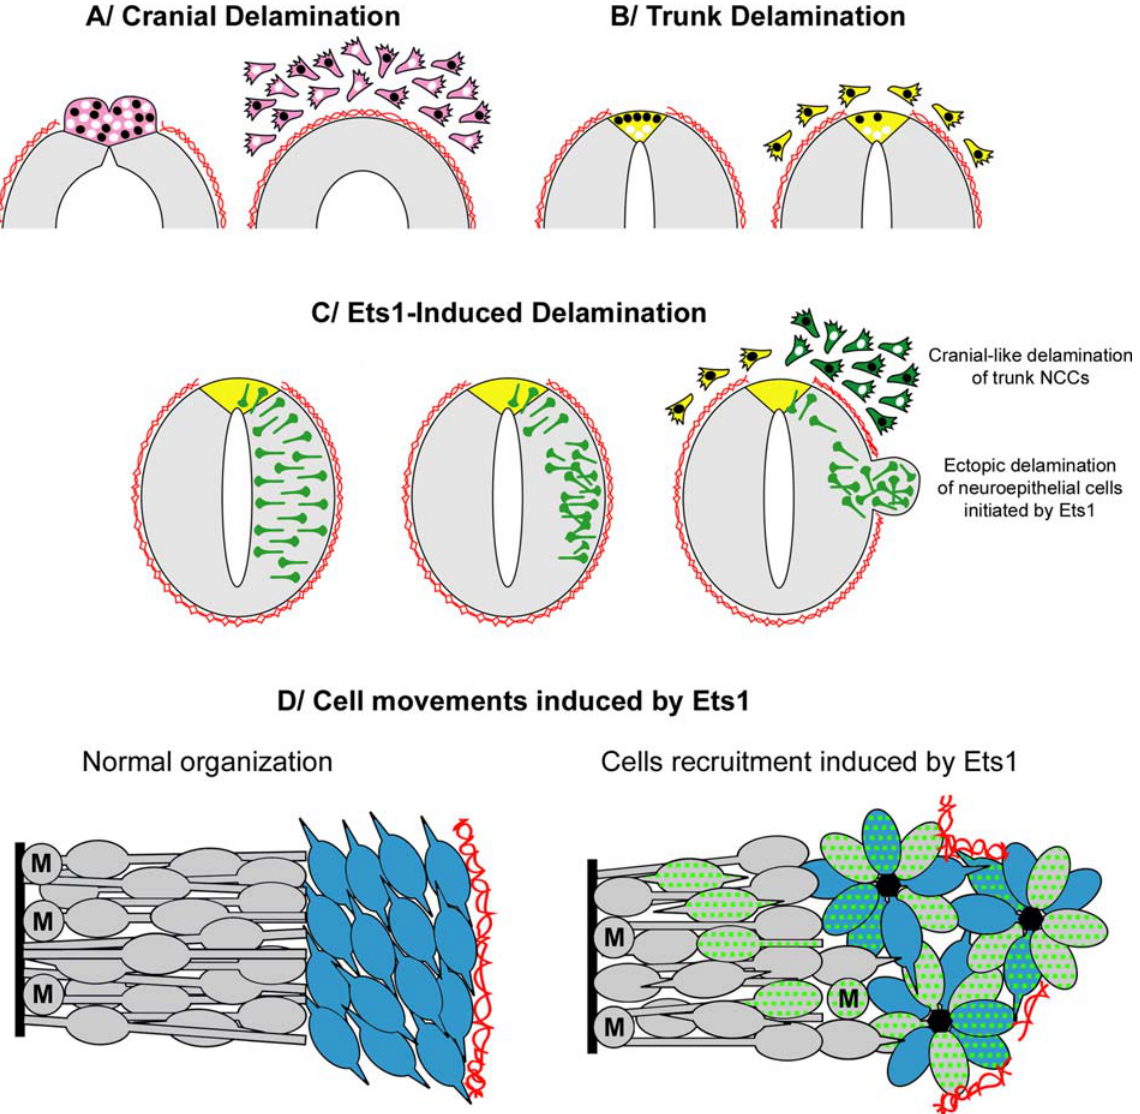
Figure 11. Ets-1 confers cranial features on neural crest delamination. (A) Normal delamination of cranial NCCs. Premigratory and migratory NCCs expressing ets-1 are in purple. (B) Normal delamination of trunk NCCs. Premigratory and migratory NCCs are in yellow. (C) Consequences of ets-1 electroporation in trunk neural tube at dorsal and at intermediate to ventral levels. Ets-1 electroporated cells are coloured in green. (D) Cell movements induced by ets-1 expression. Proliferating cells are in grey, non-proliferating cells are in blue. Ets-1 electroporated cells are dotted in green. Cell-cell junctions involving N-cadherin are represented by black centers. Nuclei in S-phase are colored in black. Basal lamina is represented by twisted red line. Cranial NCCs express ets-1 and massively delaminate independently of G1/S transition (A) whereas trunk NCCs do not express ets-1 and delaminate progressively as a cell population subjected to successful G1/S transition (B). When ets-1 expression is forced in the dorsal part of trunk neural tube, trunk NCCs delamination is greatly enhanced and cells emigrate as multilayered streams (C, green cells). Moreover, they lose their subjection to cell cycle progression indicating that ets-1 converts trunk delamination into cranial-like emigration (C). Ectopic ets-1 expression in ventral part of the neuroepithelium leads to massive cell movements without affecting cell proliferation or differentiation. Electroporated cells are accumulated close to the basal side of the neural tube and the basal lamina is degraded (C, D). These events are sufficient to initiate delamination. However, other factors such as snail-2 are required to perform full delamination and promote EMT and cell migration. M, cell in